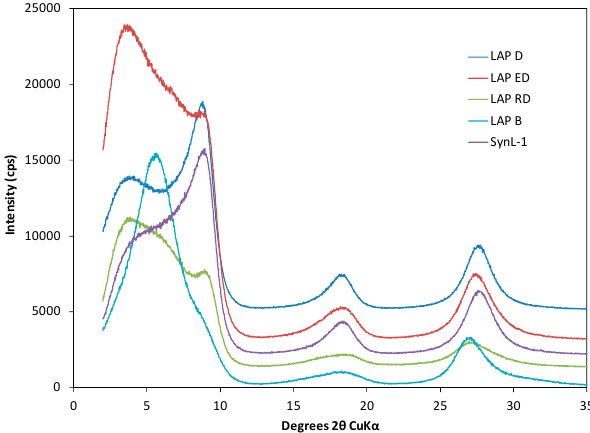
Figure 3. XRD traces of the synthetic Mg-Li smectite samples from first and second sample sets after heating at 500 °C and subsequent EG solvation.